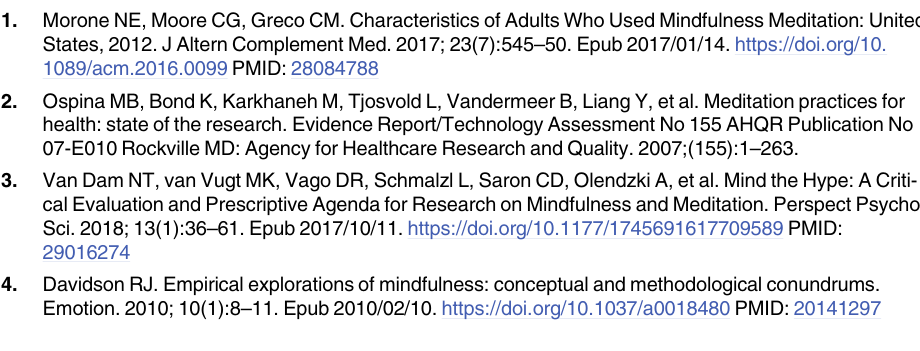
S1 Table. Between-group differences in stress, anxiety and depression at weeks 8 and 20. S2 Table. Within-group differences in stress, anxiety and depression comparing baseline to weeks 8 and